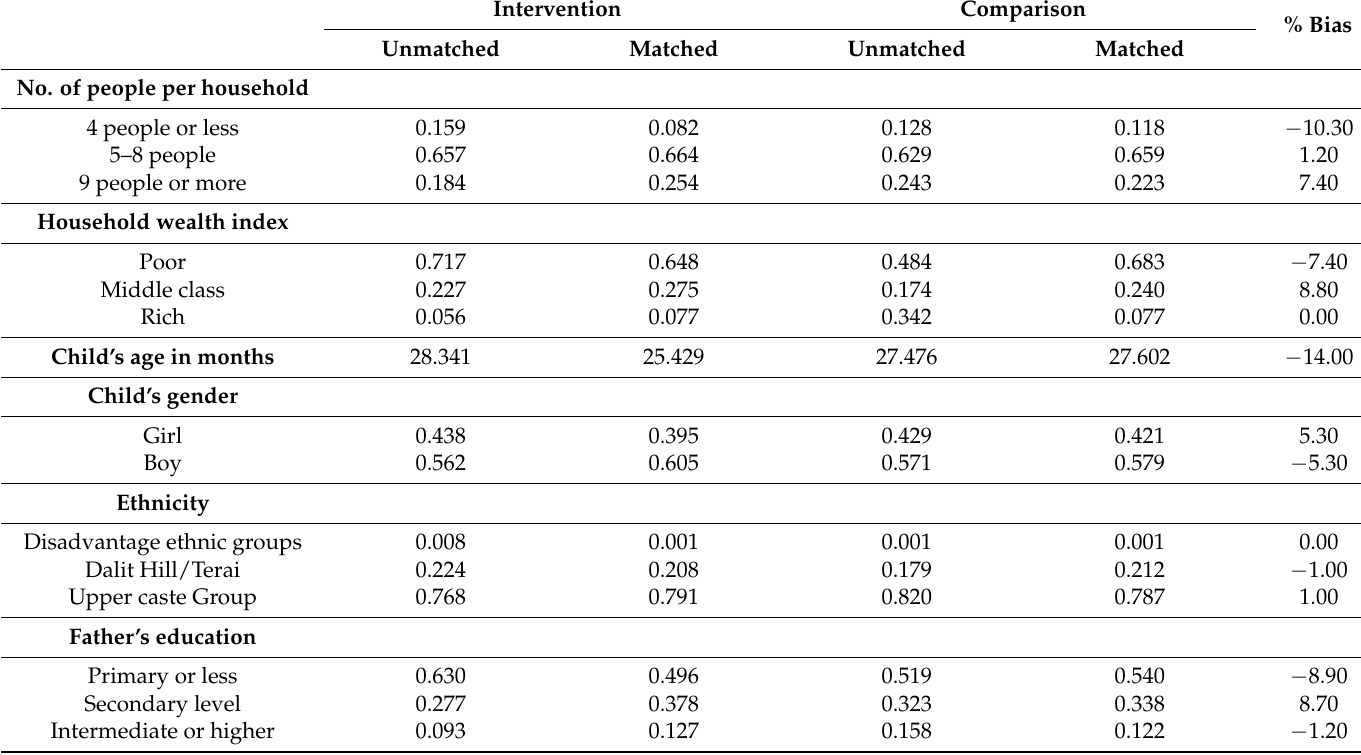
Table 3. Evaluation of standardized differences in matched